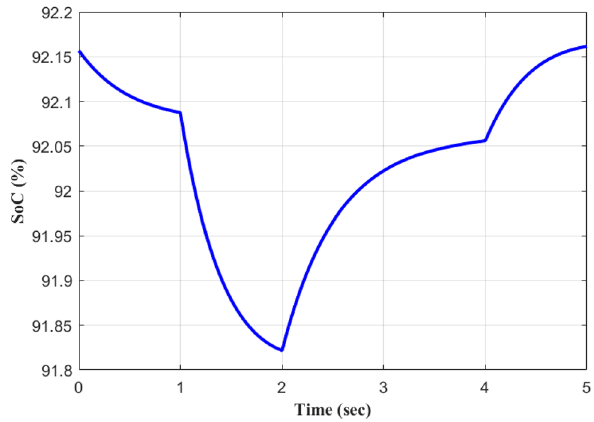
Fig. 14 The stat of charge (SoC) of the supercapacitor